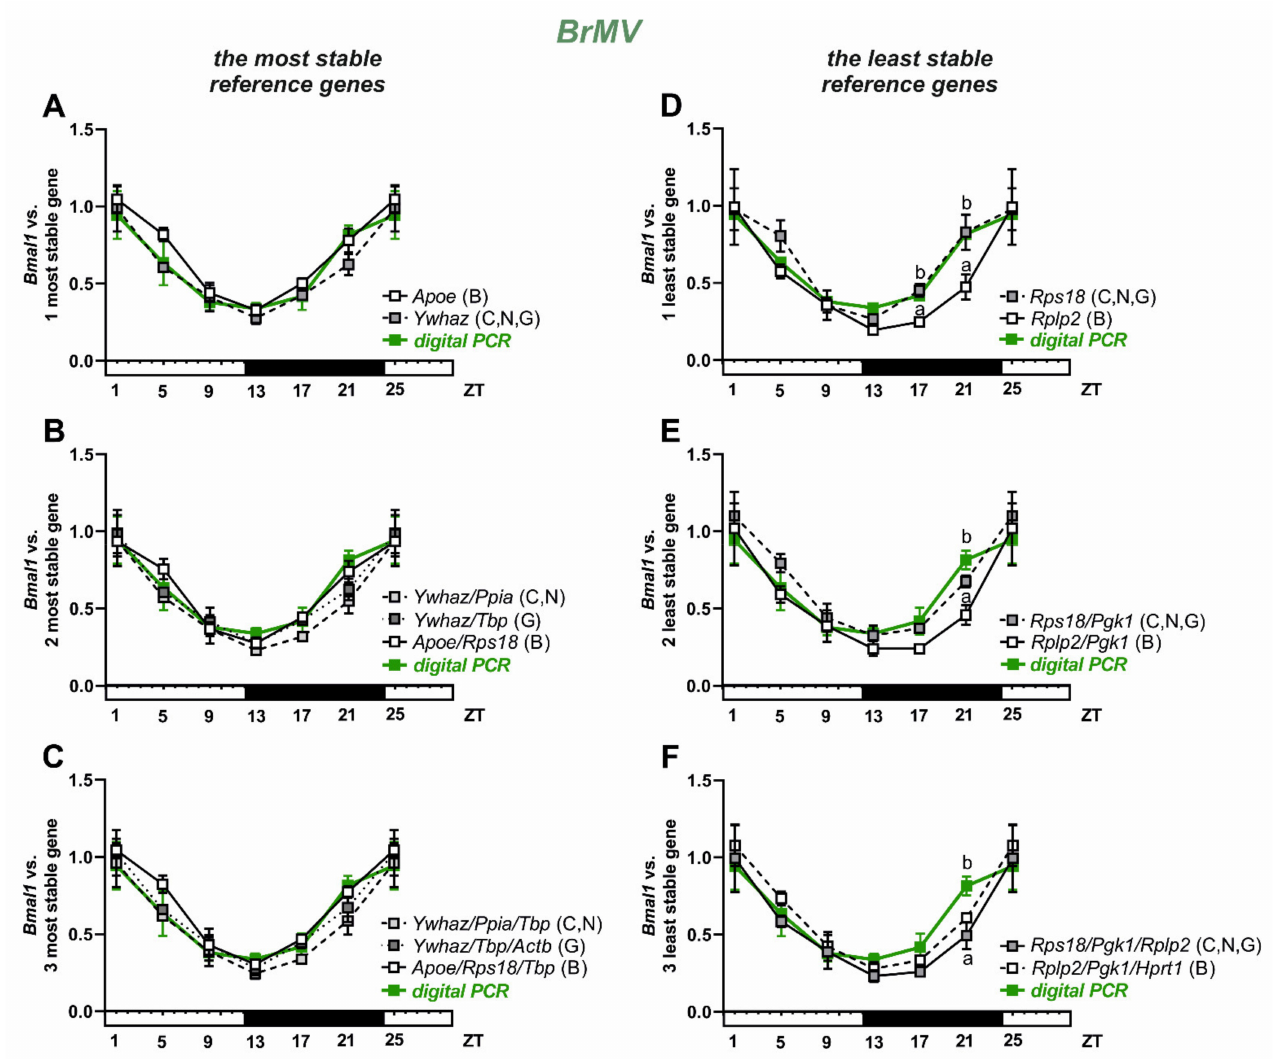
Figure 5. Relative expression of Bmal1 in isolated rat brain microvessels (BrMV; n = 6, 6 females/3 samples and 6 males/3 samples for each time point). Data from ZT1 and ZT25 (ZT-Zeigeber Time) are double plotted in all panels. Data calculated vs. reference genes selected as the most stable, left panels ( A – C ), and the least stable, right panels ( D – F ). The additional green plot refers to digital PCR results and different lower case letters indicate significant differences at p < 0.05 between qPCR and digital PCR results at a given time point. Abbreviations: C— ∆ Ct, B—BestKeeper, N—NormFinder,